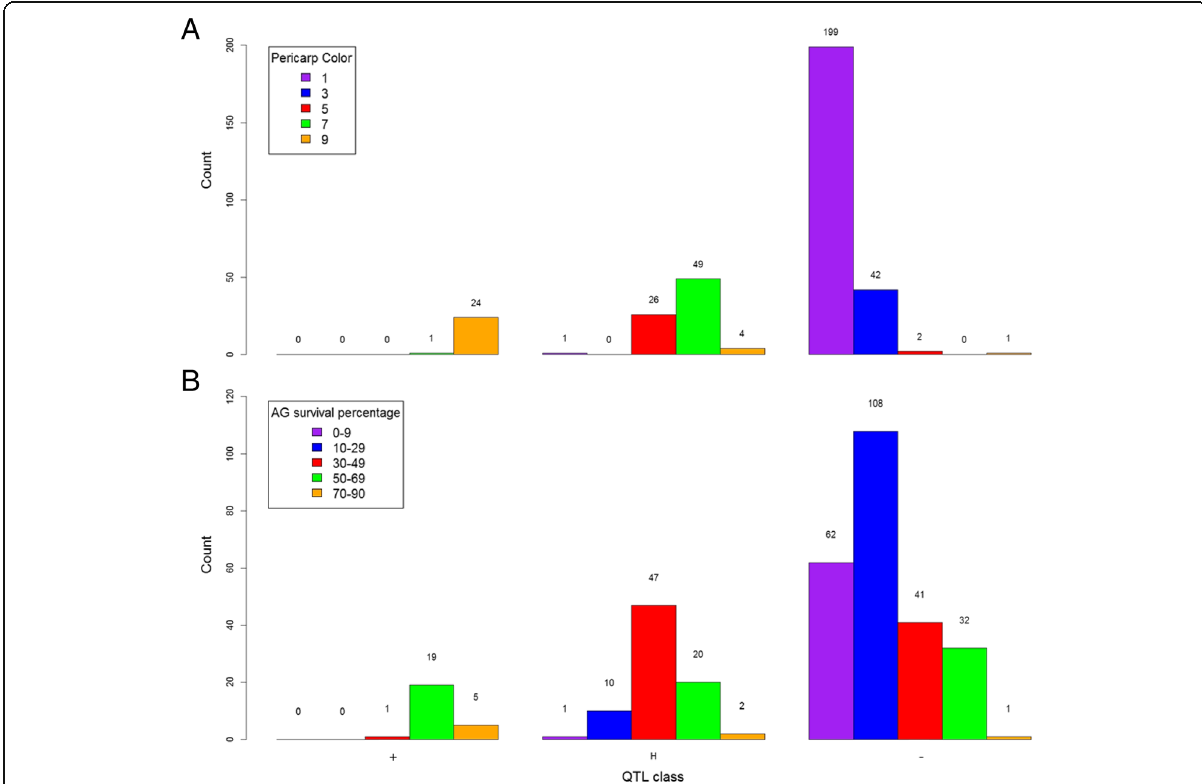
Fig. 6 Frequency distribution of pericarp color ( a ) and germination percentage ( b ) within QTL allele classes across the two populations. + refers to lines with Kalarata allele, − refers to lines with Rc222/Rc238 allele, and H refers to heterozygote for the peak marker of qSUR7 –